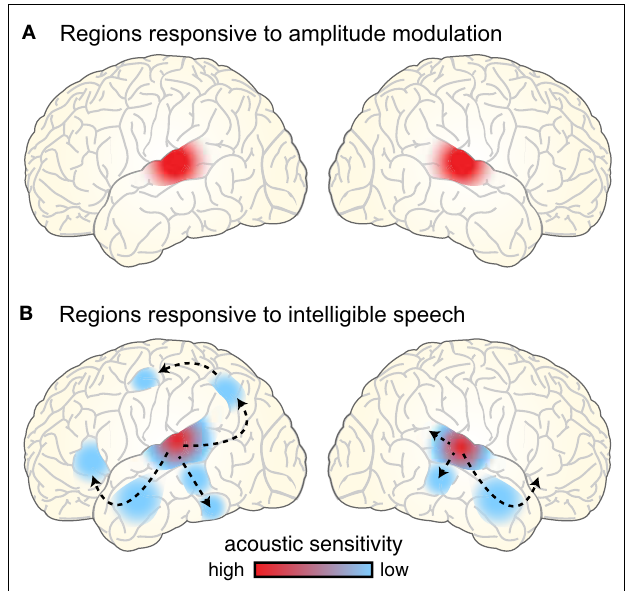
FIGURE 7 | (A) Brain regions responding to amplitude-modulated acoustic stimulation. (B) Brain regions responding to intelligible speech > temporally complex control conditions. Intelligible speech – i.e., amplitude-modulated acoustic stimulation that conveys linguistic information – recruits a broad network of bilateral cortical regions that are organized into parallel hierarchies.Within this network, regions show differential sensitivity to the surface features of speech (i.e., acoustic information), with areas removed from primary auditory cortex primarily responding to the degree of linguistic information in the speech (Davis and Johnsrude,